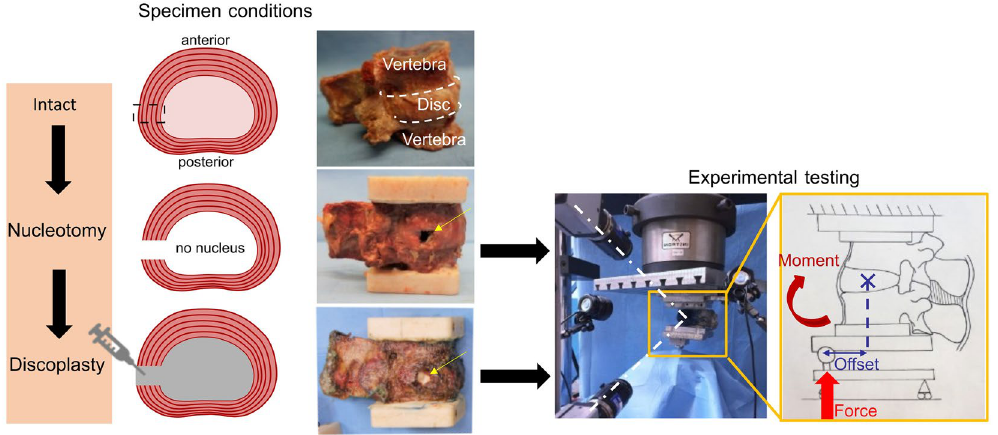
Figure 1. Preparation and test of one specimen in flexion. The discs were tested in nucleotomy and discoplasty. The eccentric load was applied to create the bending moment (in flexion here) while DIC system recorded the specimen position (white dot